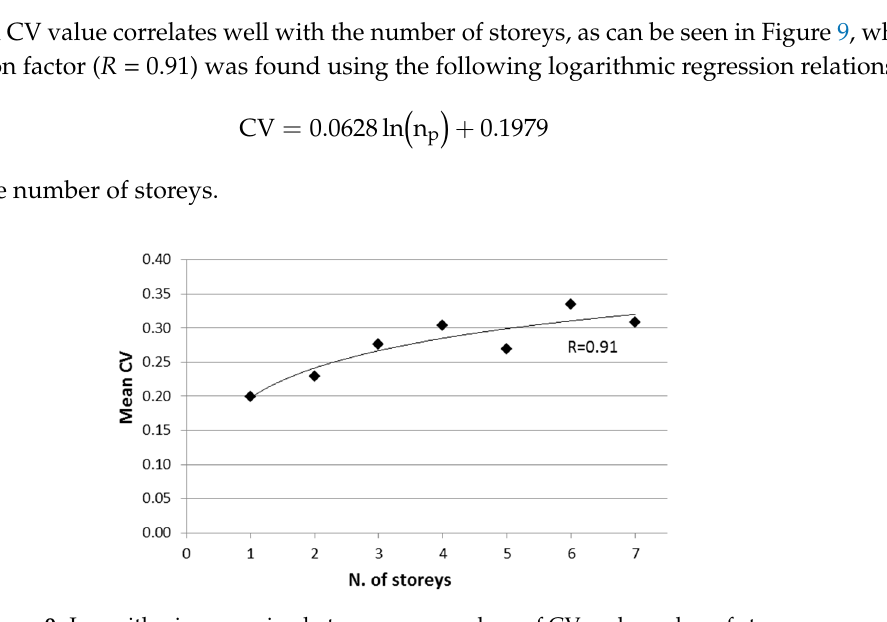
Figure 8. Box-plot of statistical data with respect to the number of storeys.